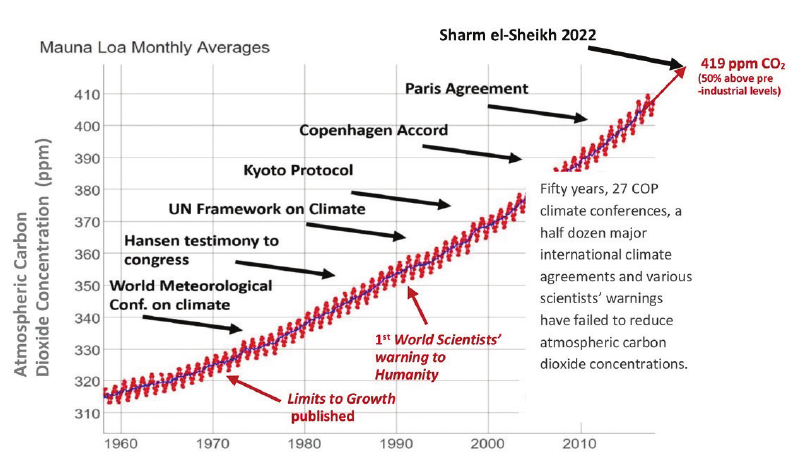
Figure 1. Failed climate action – carbon dioxide levels still climbing